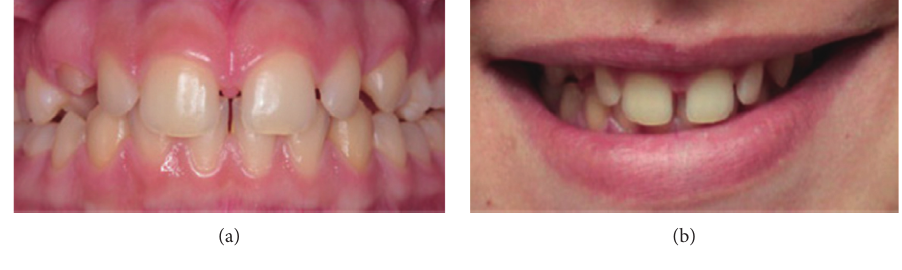
Figure 6: Severe